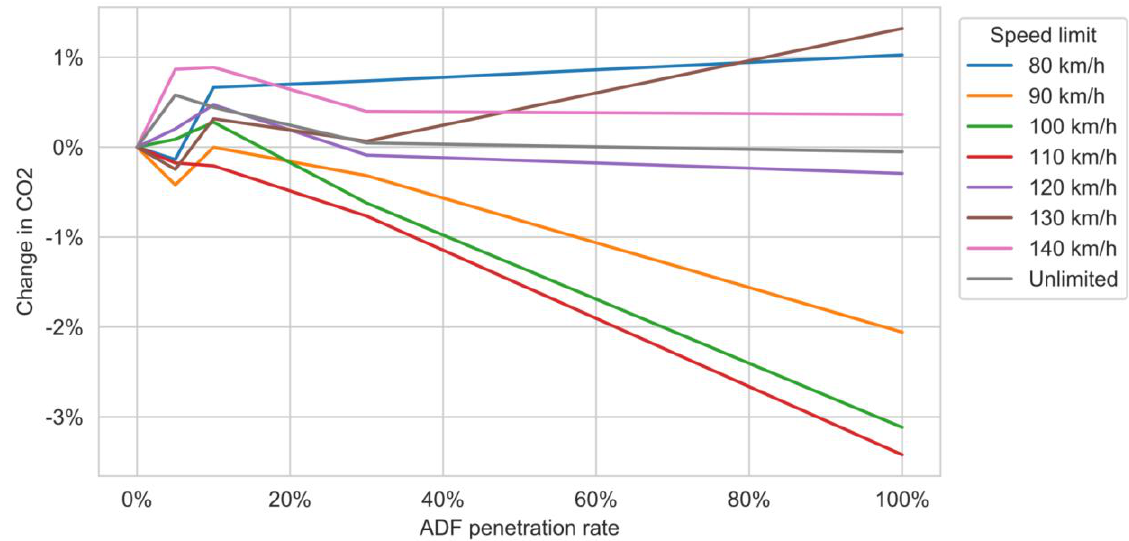
Figure 15. Scaled-up results with relative changes in CO 2 at AV penetration rates of 5%, 10%, 30% and 100% among passenger cars compared to the baseline at different speed